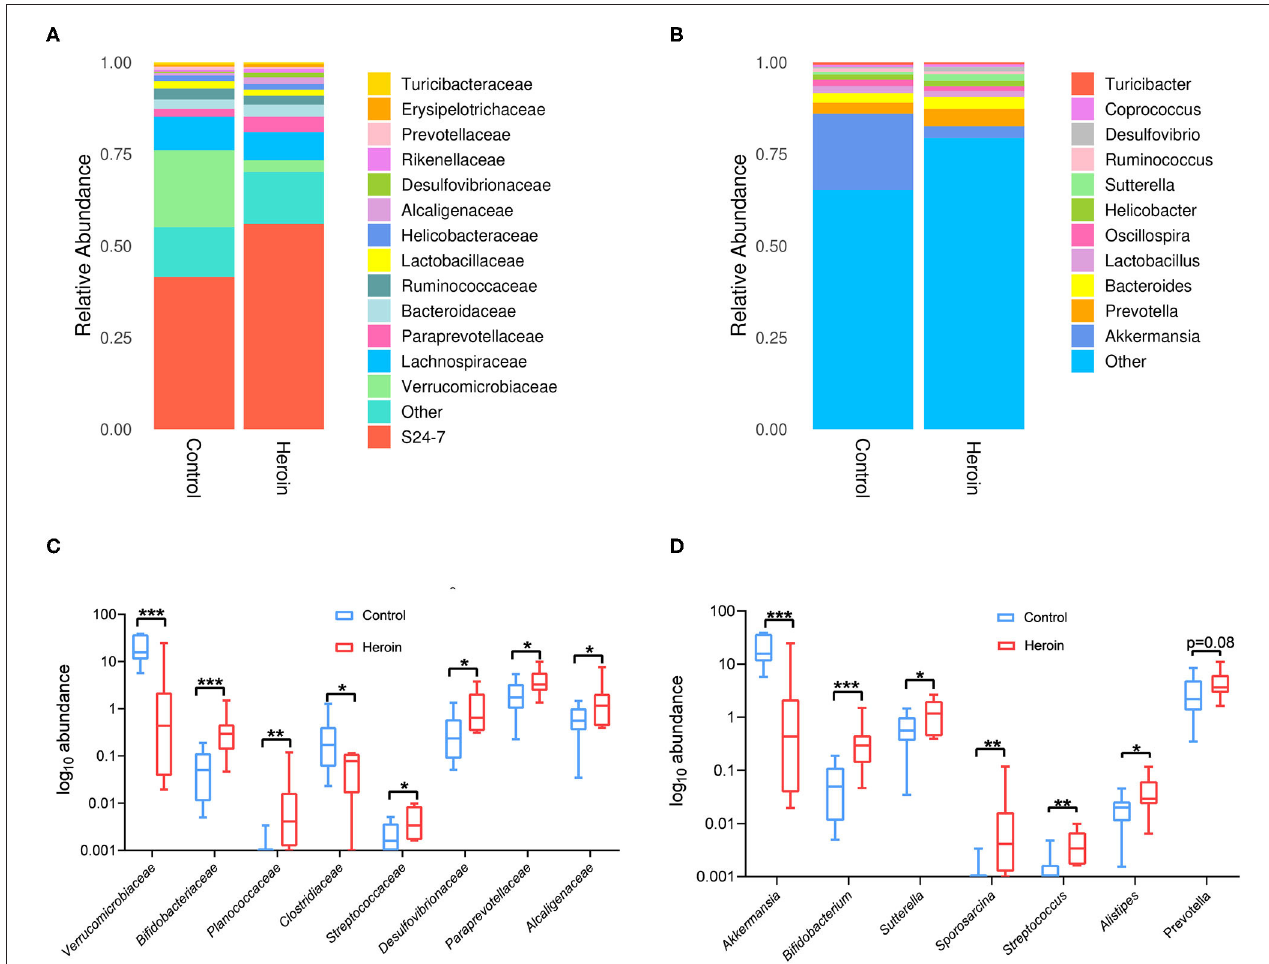
FIGURE 4 | Family and genus-level taxonomic distribution of intestinal microbiota and the top microbiota (the relative abundance > 0.01%) at the family and genus levels in the control and heroin groups. (A,B) Bacterial community structures in the heroin administrated and control groups at the family (A) and genus levels (B) . Abundance is presented in terms of the percentage of the total effective bacterial sequences in each group. (C,D) All significantly different bacterial are listed in the heroin and control groups at the family (C) and genus levels (D) . Data are represented as boxplots, with median, minima, and maxima, statistical significance was calculated using Wilcoxon-test ( n = 10) * p < 0.05; ** p < 0.01; *** p <